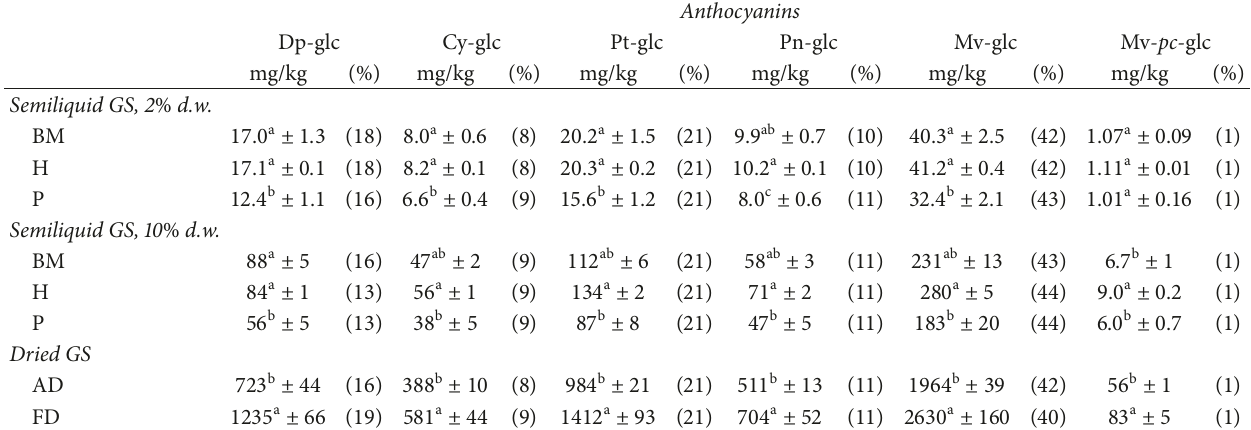
Table 3: Individual anthocyanin content (mg/kg) and relative abundance (% of total, in brackets) in GS after processing. ∗